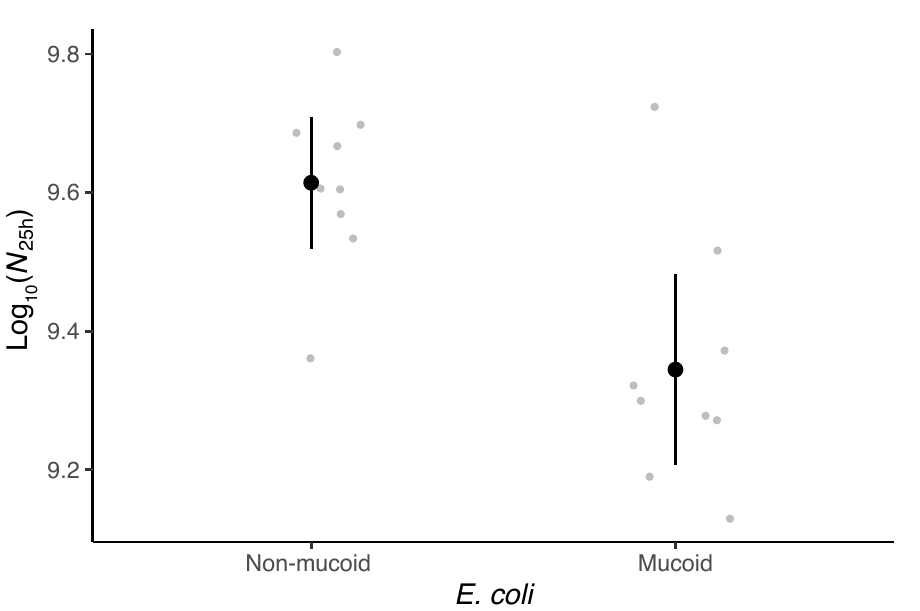
Figure 4. Mucoids have lower population productivity than non-mucoids in the absence of preda- tors. Log-transformed (productivity) is shown. Grey dots are mean values from nine coevolving populations from which the clones were isolated at the end of cycle 18. Three independent estimates were generated for each population (Figure 5c). Black dots are means across the nine populations for each prey type and error bars show 95% confidence intervals from nine replicate populations ( t